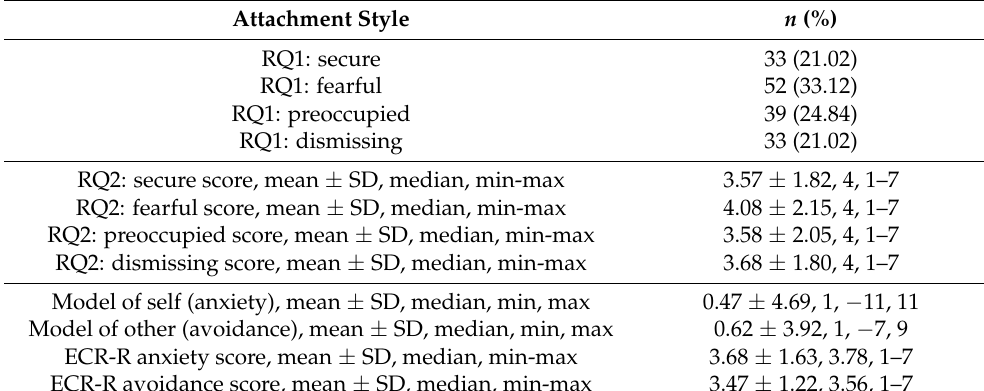
Table 2. Distribution of attachment style, mean and standard deviation of RQ and ECR-R